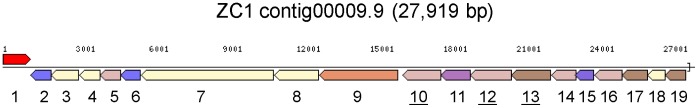
Relative abundance of COG functional categories for ZC1 and ZC2 and seven public metagenomes.Assembled sequence reads were classified into the 25 COG categories designated in Figure 5 and their relative abundances for each metagenome were estimated considering the respective total number of protein coding sequences with function prediction. The public metagenomes included in the comparison are benzene-degrading bioreactor, biofuel reactor, compost minireactor, termite hindgut, poplar biomass bioreactor, lake sediment and soil rain forest, whose features are listed in Table S5. Asterisks indicate statistically significant values.